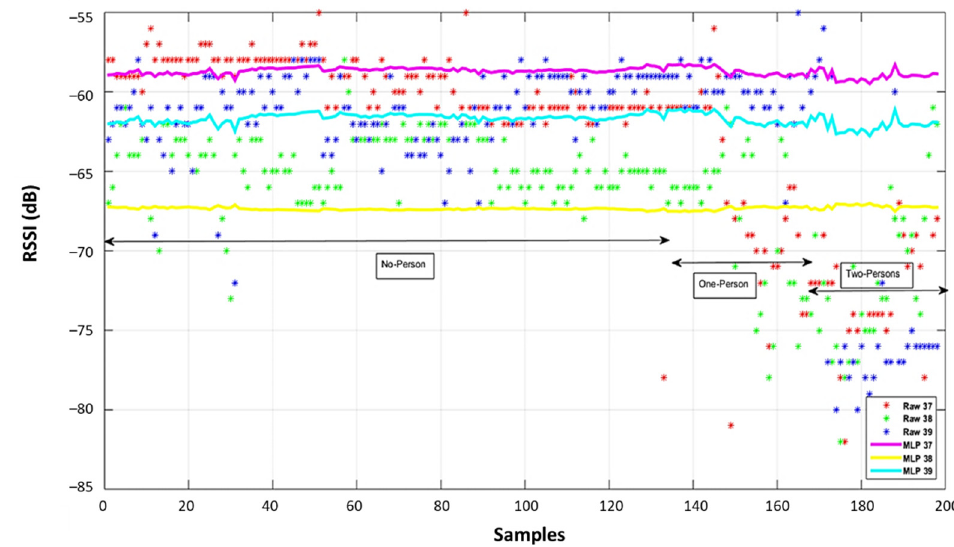
Figure 19. Comparison of the collected RSSI values in bind points before and after ANNs.